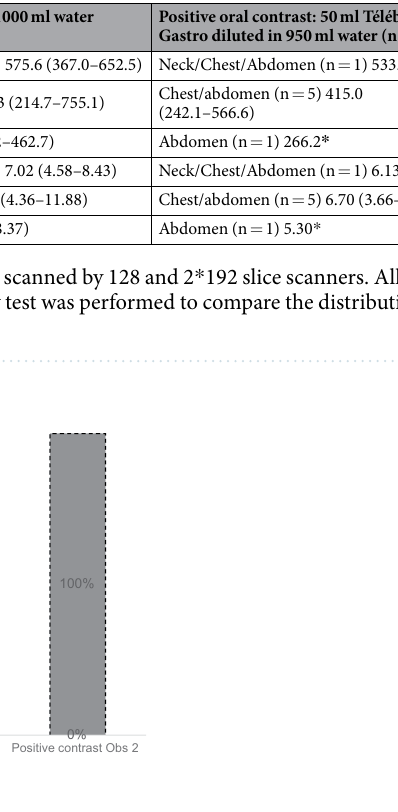
Figure 2. The quality of de scans assessed by observer 1 and observer